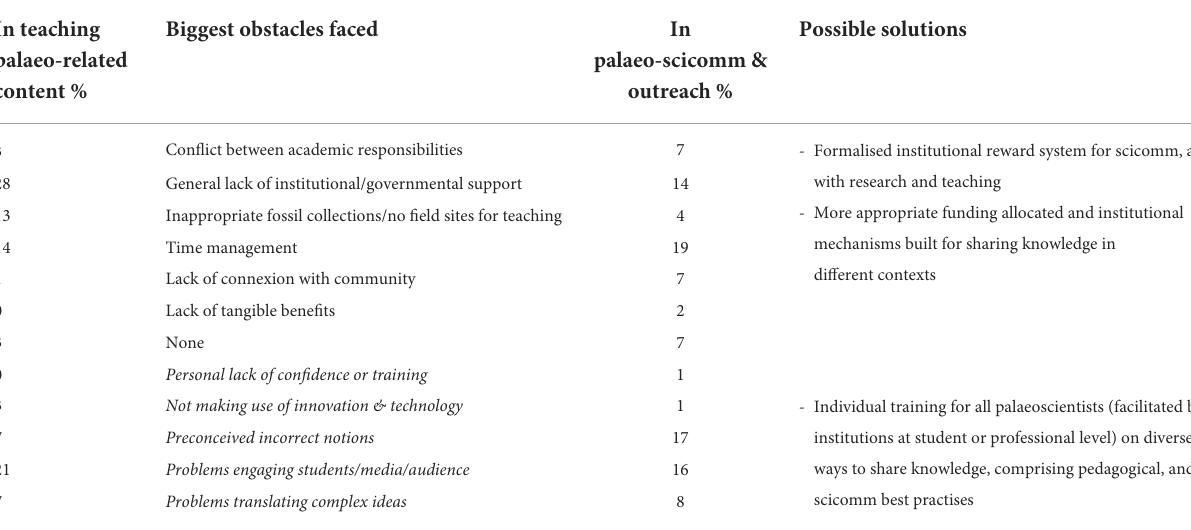
TABLE 2 Survey respondents’ views of the biggest obstacles faced in palaeoscience-related teaching and outreach (respondents could list multiple